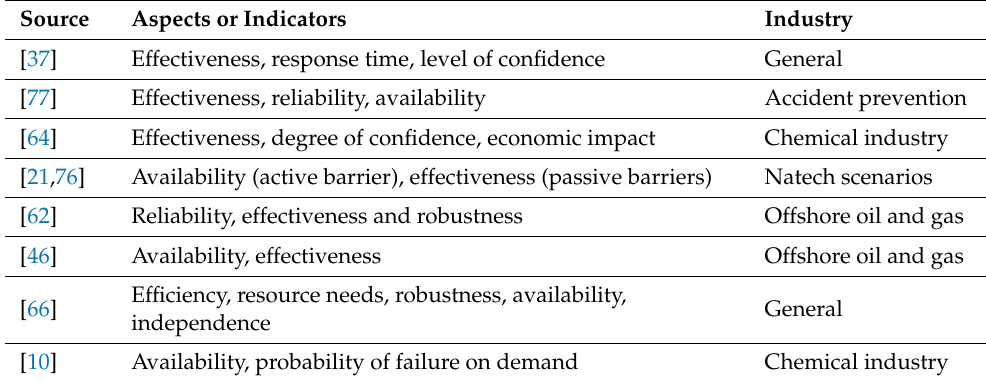
Table 4. Indicators or aspects used in safety barrier performance